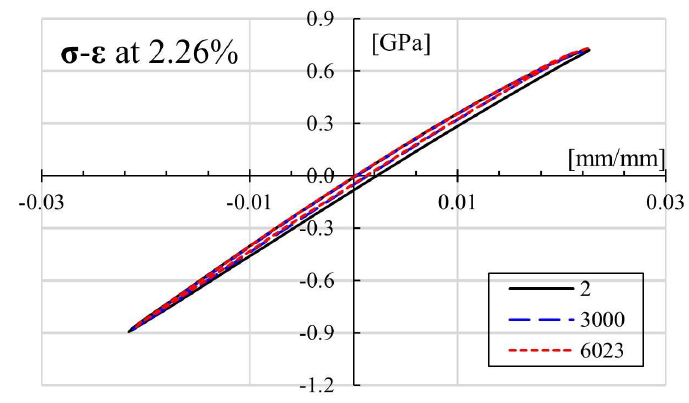
Figure 9. Exemplary result for the hysteresis loops at ± 2.26% ε.